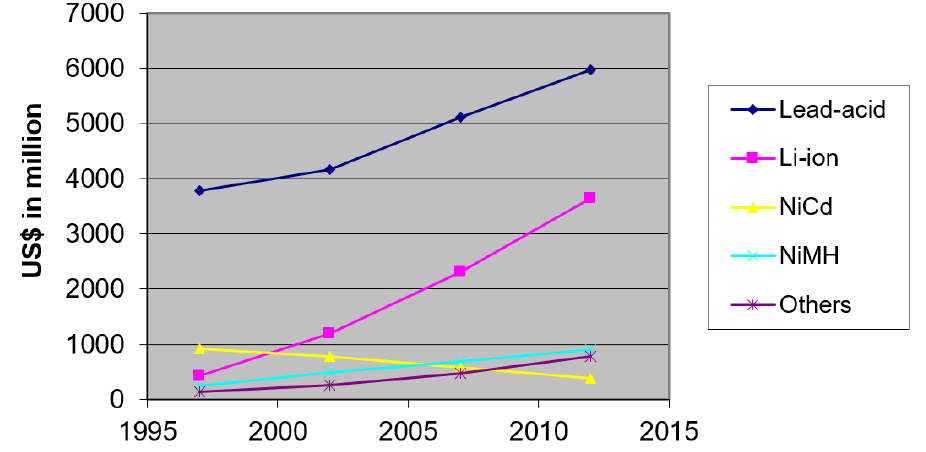
Figure 1. Demands of rechargeable batteries in the world